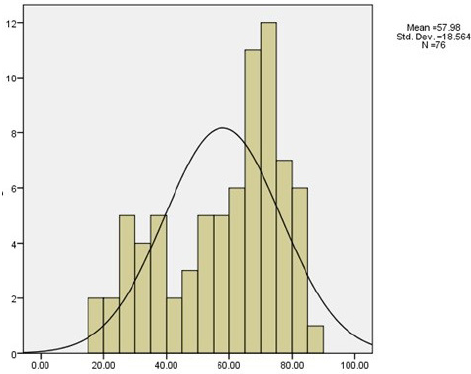
Figure 4. The diameter of the inferior vena cava during resuscitation (horizontal) by frequency